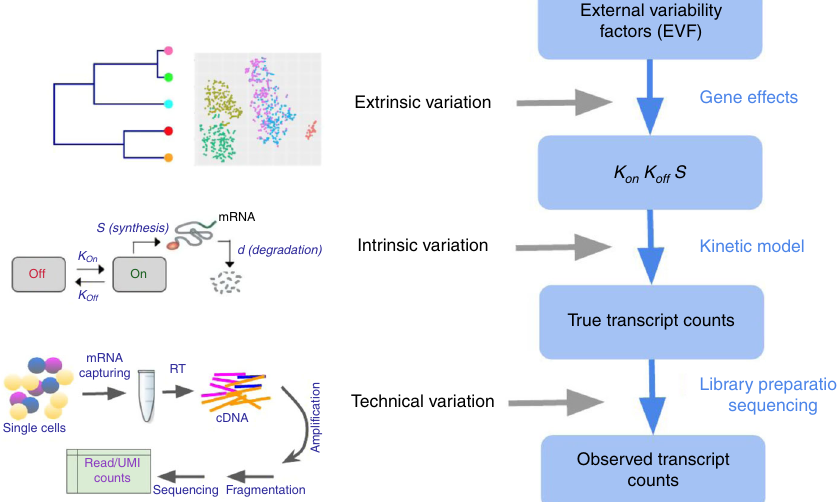
Fig. 1 Overview of SymSim. The true transcript counts, which are the number of molecules for each transcript in each cell at the time of analysis, are generated through the classical promoter kinetic model with parameters: promoter on rate ( k on ), off rate ( k off ) and RNA synthesis rate ( s ). The values of the kinetic parameters are determined by the product of gene-speci fi c coef fi cients (termed gene effects) and cell-speci fi c coef fi cients. The latter set of coef fi cients is termed extrinsic variability factors (EVF), and it is indicative of the cell state. The expected value of each EVF is determined in accordance to the position of the cell in a user-de fi ned tree structure. The tree dictates the structure of the resulting cell – cell similarity map (which can be either discrete or continuous) since the distance between any two cells in the tree is proportional to the expected distance between their EVF values. For homogenous populations (represented by a single location in the tree), the EVFs are drawn iid from a distribution whose mean is the expected EVF value and variance is provided by the user. From the true transcript counts we explicitly simulate the key experimental steps of library preparation and sequencing, and obtain observed counts, which are read counts for full-length mRNA sequencing protocols, and UMI counts,